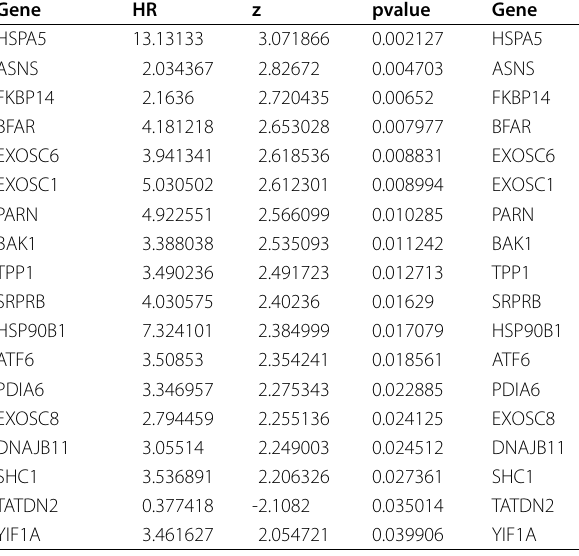
Table 5 The correlation of the ERS-related signature with clinical characteristics of HNSCC.